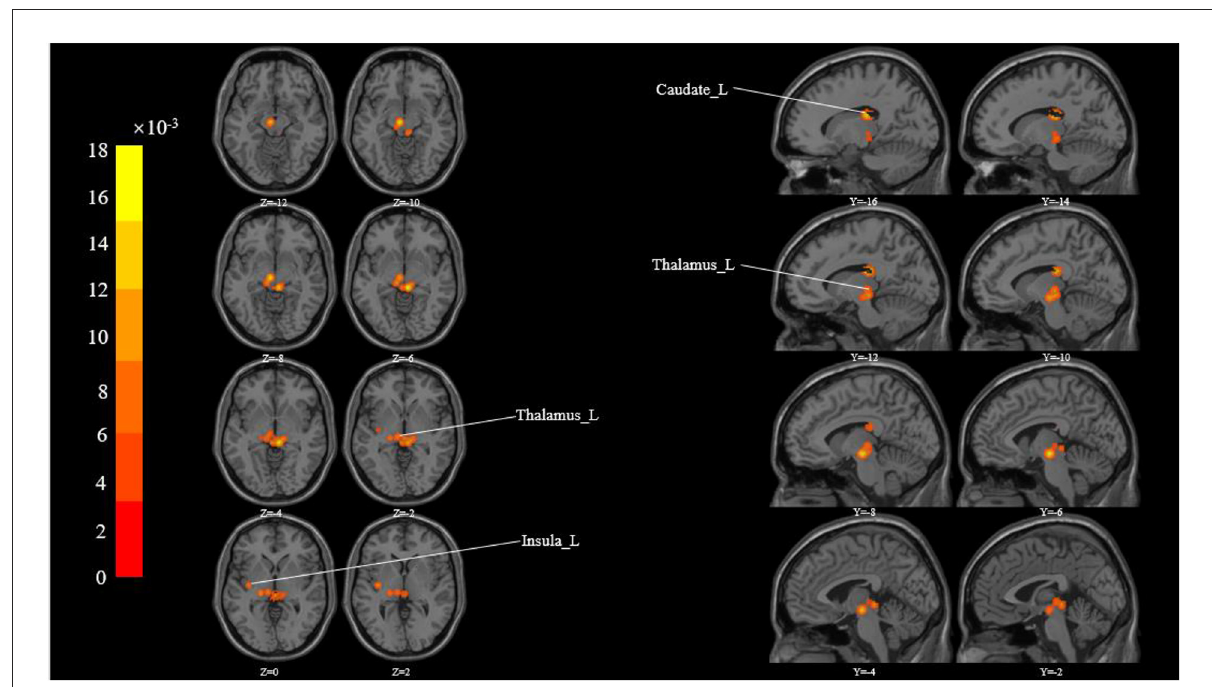
FIGURE2 All activation likelihood estimate results for studies measuring. Cluster-level Inference P-FWE < 0.05, Permutations = 5000 Cluster-Forming P- Uncorrected <